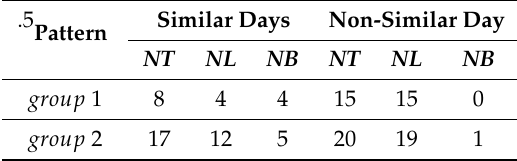
Table 6. The results of